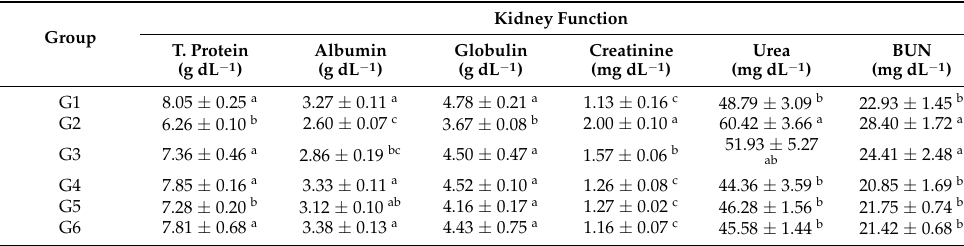
Table 6. The effect of FS and FSS extracts on kidney function in CCl 4 -induced nephrotoxicity and oxidative stress in rats (mean ± SE), n = 8.